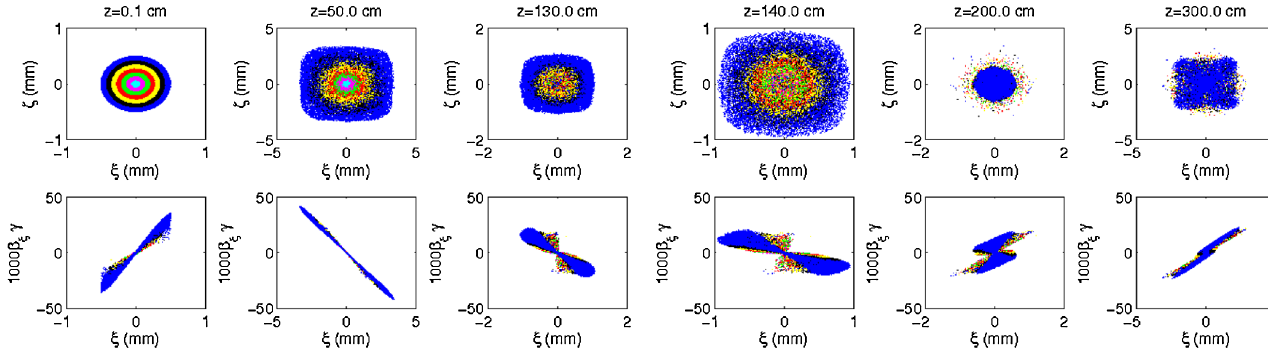
FIG. 11. (Color) Macroparticle distributions in the transverse configuration space (top) and transverse horizontal phase space (bottom) at different locations from the photocathode surface ( z ¼ 0 : 1 , 50, and 130, 140, 200, and 300 cm from left to right columns) associated to the central beamlet with the peripheral beamlets. The peak B-field of L3 is ^ B ¼ 0 : 376 T . The coordinate system is the Larmor frame ð (cid:10); (cid:11) Þ . The color coding corresponds to different radial slices at the emission time (the beam at emission was divided into seven radial slices of same thickness (cid:7)r ’ 70 (cid:1) m